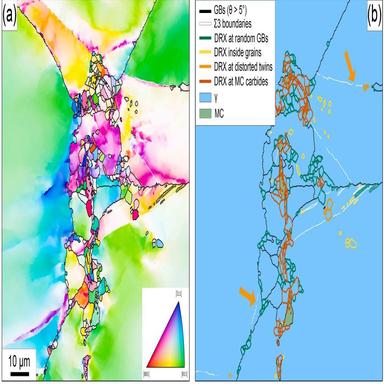
Alloy 2 compressed at 1050 ◦C with a 0.1 s − 1 strain rate to 0.6 strain; (a) IPF map in direction of deformation and (b) phase map overlayed with the results from the location-based grain classification methodology that categorised recrystallised grains. Random GBs with θ > 5◦ are indicated in black, Σ3 twin boundaries are marked in white. The orange arrows indicate examples of distorted twins.